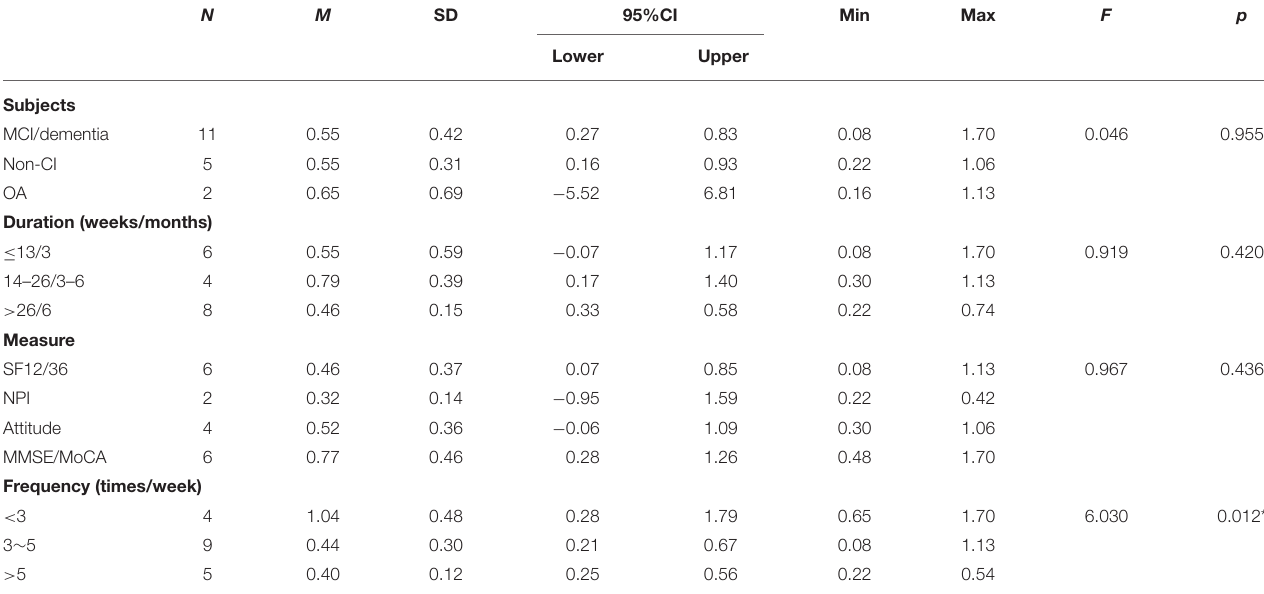
TABLE 3 | Outcomes for descriptive statistics and ANOVA. N M SD 95%CI Min Max F p Lower